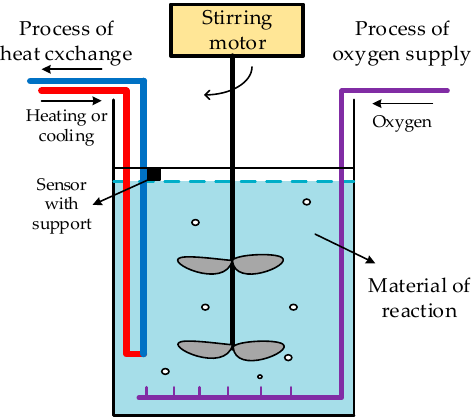
Figure 1. Schematic of biological oxidation pretreatment.